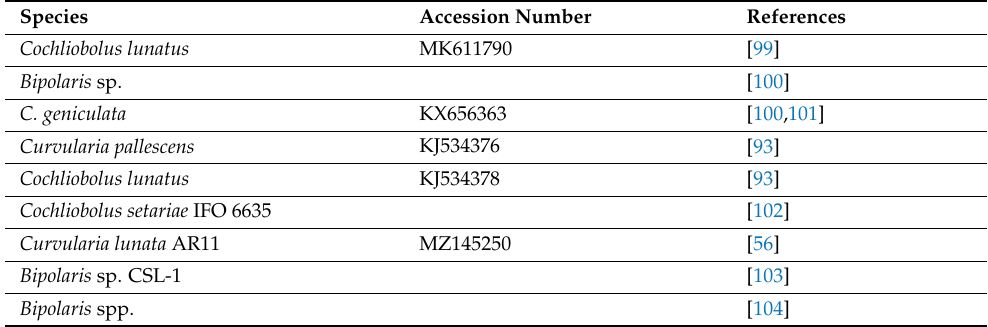
Table 3. Fungal species with plant growth-promoting